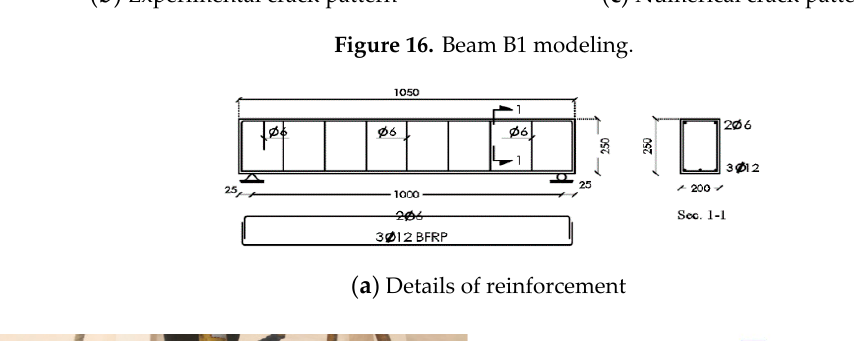
Figure 16. Beam B1 modeling.